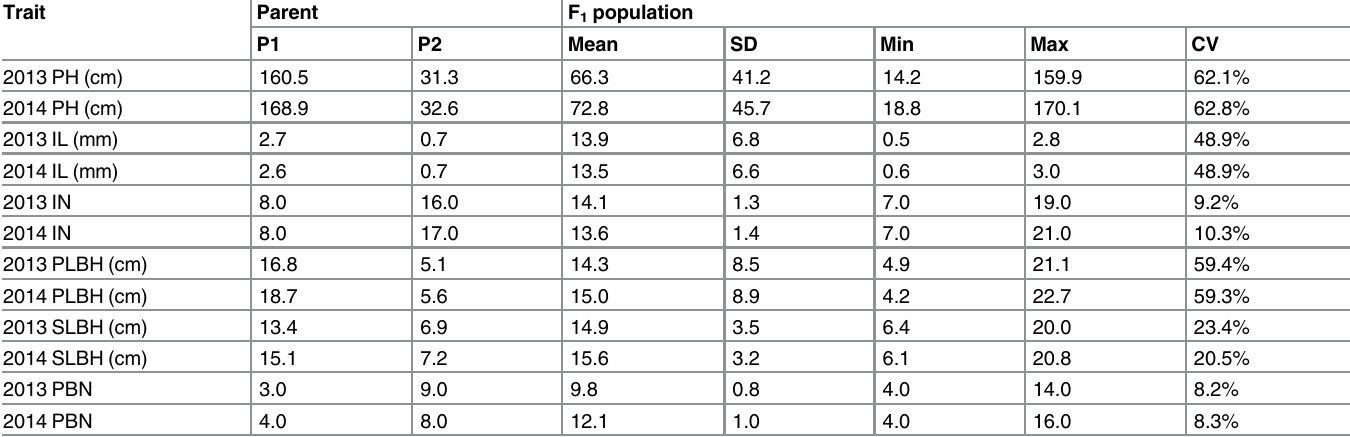
variation for PH, PLBH and IL than IN, SLBH and PBN in the two years. The frequency distri- and parent lines showed that the PH was controlled by a bution of the plant height in the F 1 major gene plus polygenes and was suitable for the bulked segregant analysis (Fig 3), which was consistent with previous work [37]. Each phenotypic trait between the 2 years was signifi- cantly correlated with a correlation coefficient > 0.9 (P < 0.01). The Pearson correlation coeffi- cients between the six traits are described in Table 2. The PH trait showed a significant positive correlation with the IL, PLBH, and SLBH and a negative correlation with the PBN. Although we evaluated the IL, IN, PLBH, SLBH and PBN as different traits to determine the PH, only the IL and the PLBH could be used as representative indexes of PH. The scatter plots are shown in Fig 4. The R 2 values between the PH and IL and between the PH and PLBH were 0.570 and 0.615, respectively, which indicated that early predictions and indirect selection for plant height using IL and PLBH are practical for use in crape myrtle breeding programs.